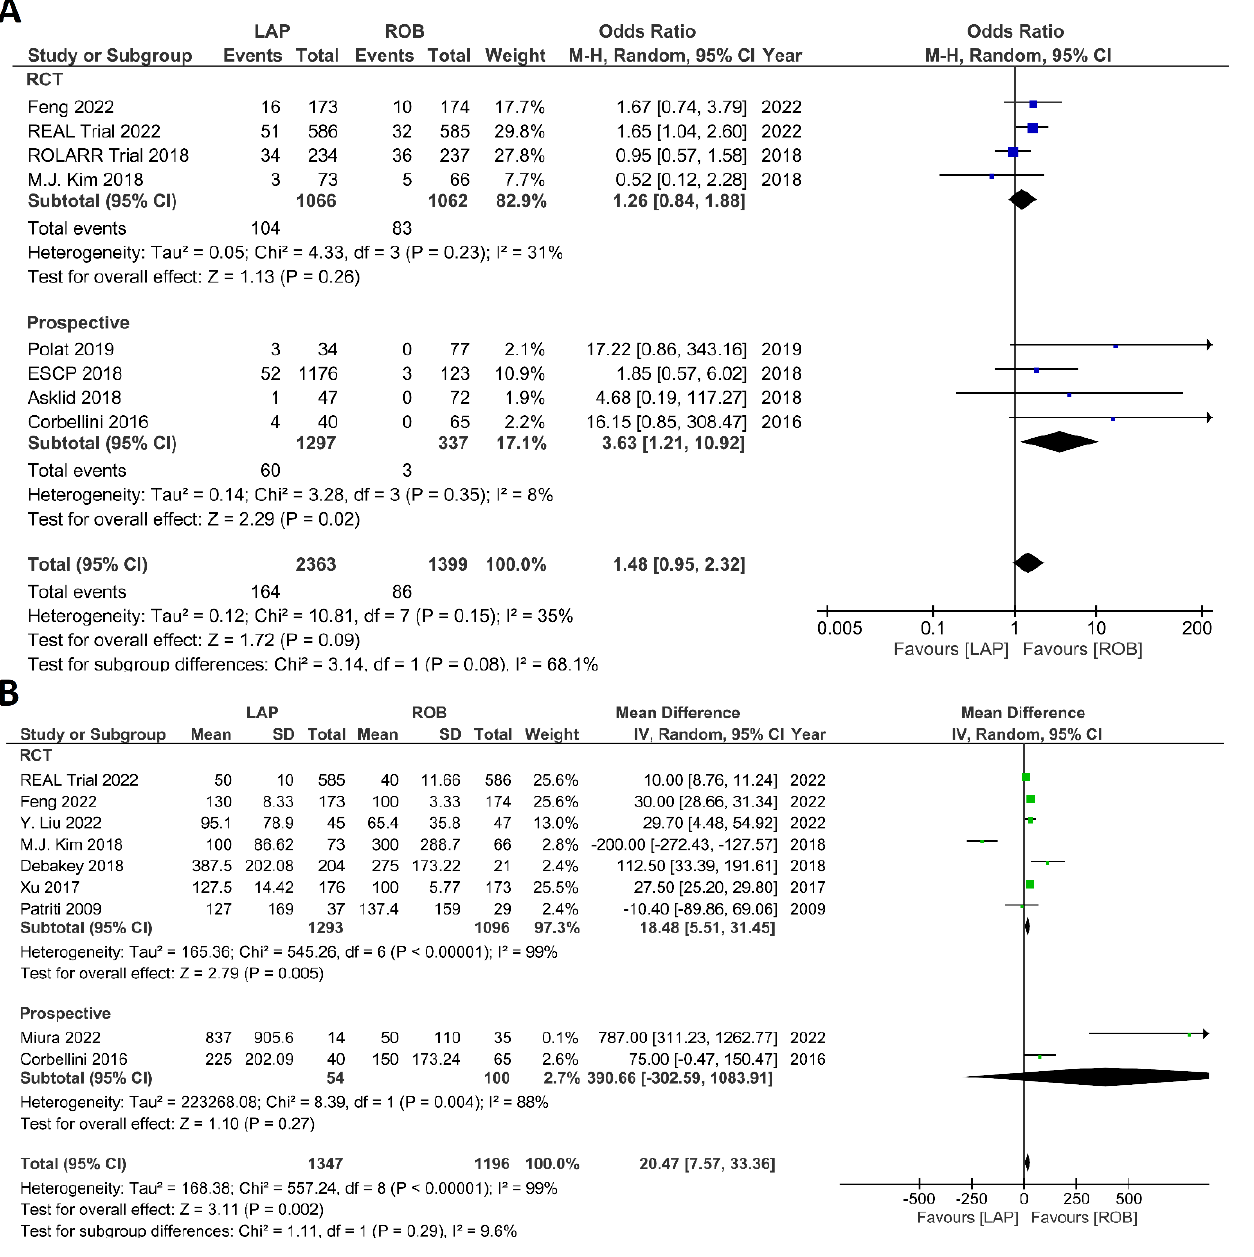
Figure 6. Forest plots comparing ( A ) intraoperative complications [17–19,34,41,42,44,45,52] and ( B ) estimated blood loss [17,18,35,37,40–43,51] between robotic and laparoscopic rectal resection (blue boxes representing odd ratios, green boxes representing mean differences, arrows represent- ing 95% confidence intervals, and diamonds representing point estimates of pooled odd ratios or mean differences).